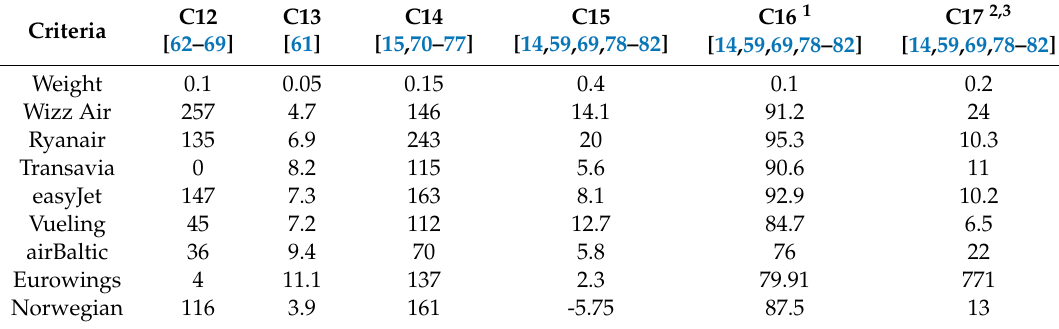
Table 4. Input for successfulness TOPSIS. Source: compiled by the authors, see footnotes. Criteria